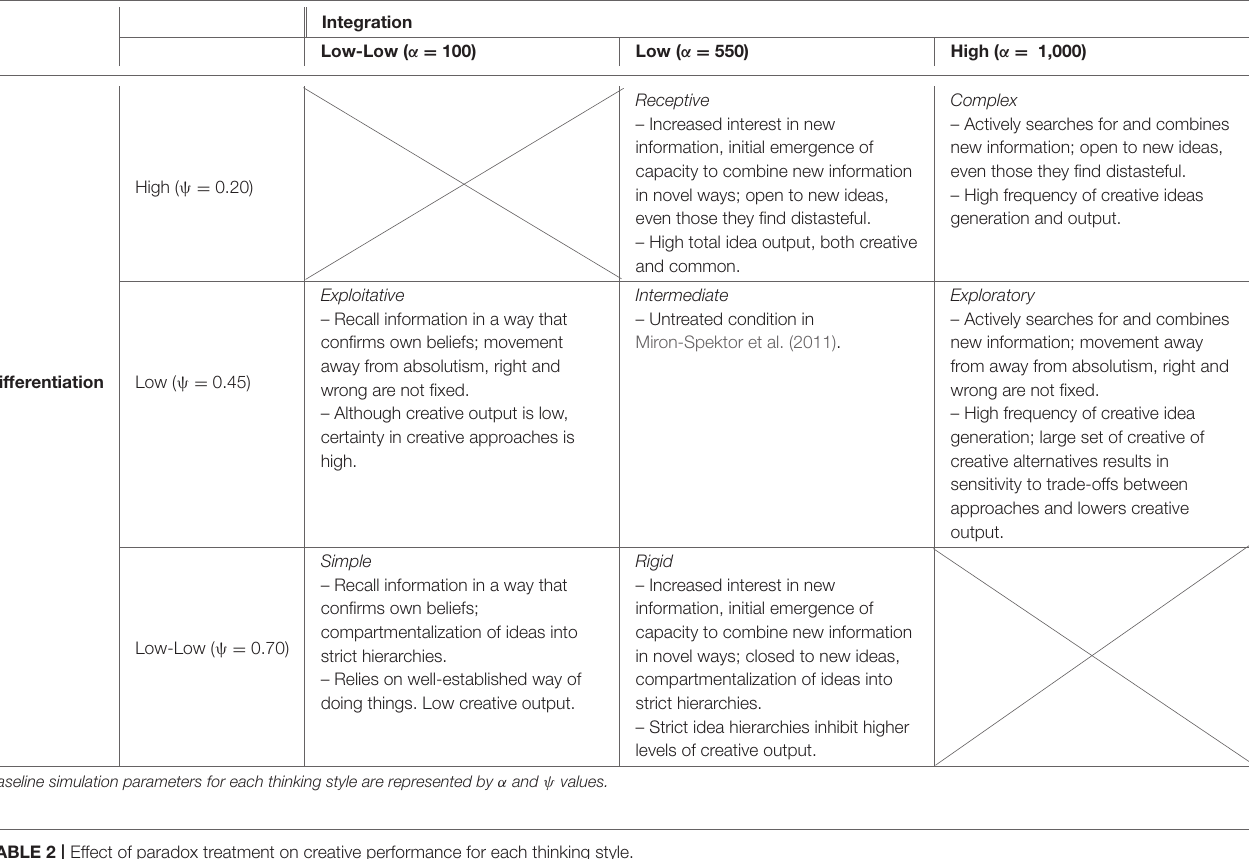
TABLE 1 | Creative thinking styles characterized by gradations in integrative complexity.